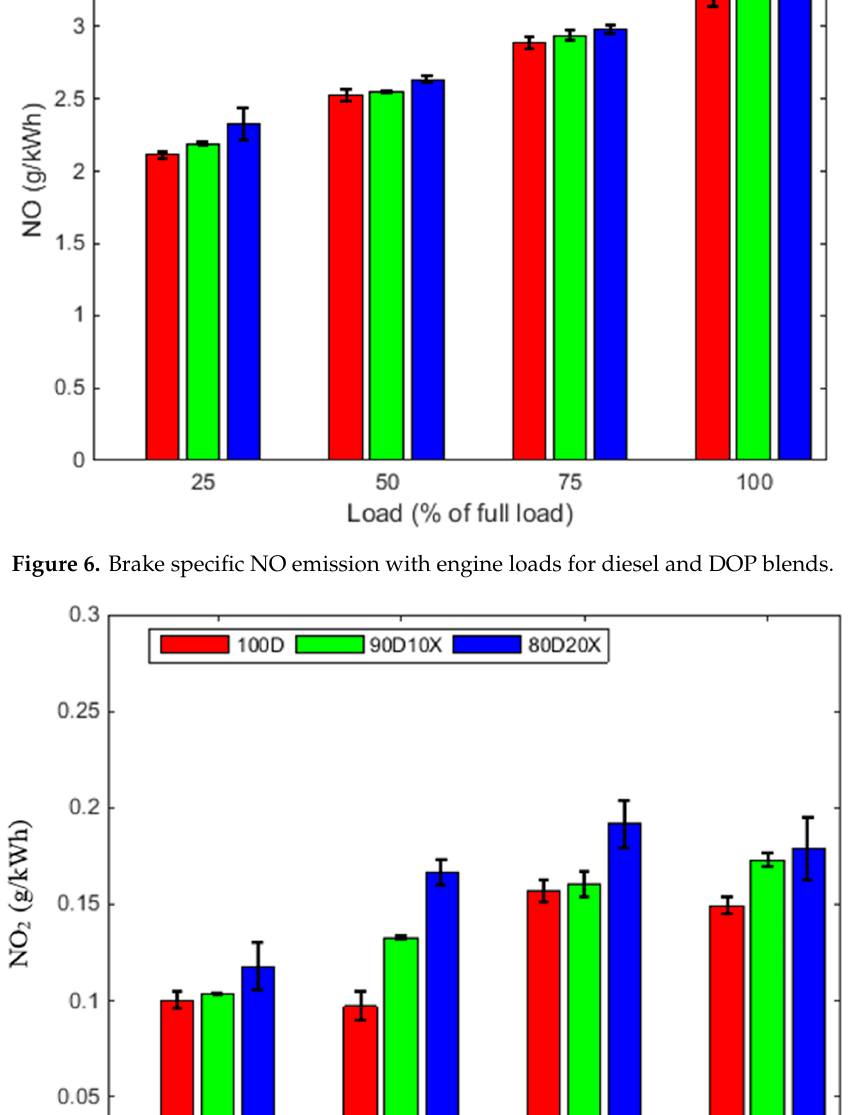
Figure 8. Brake specific NO x emission with engine loads for diesel and DOP blends.